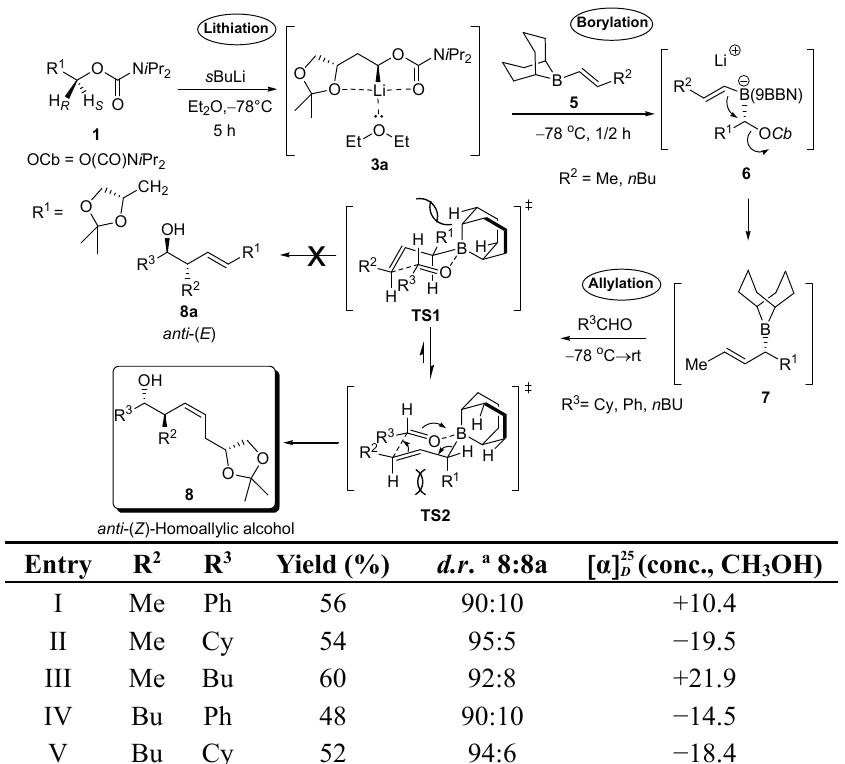
Table 2. Synthesis of anti -( Z )-homoallylic alcohols through the lithiation/allylboration method.